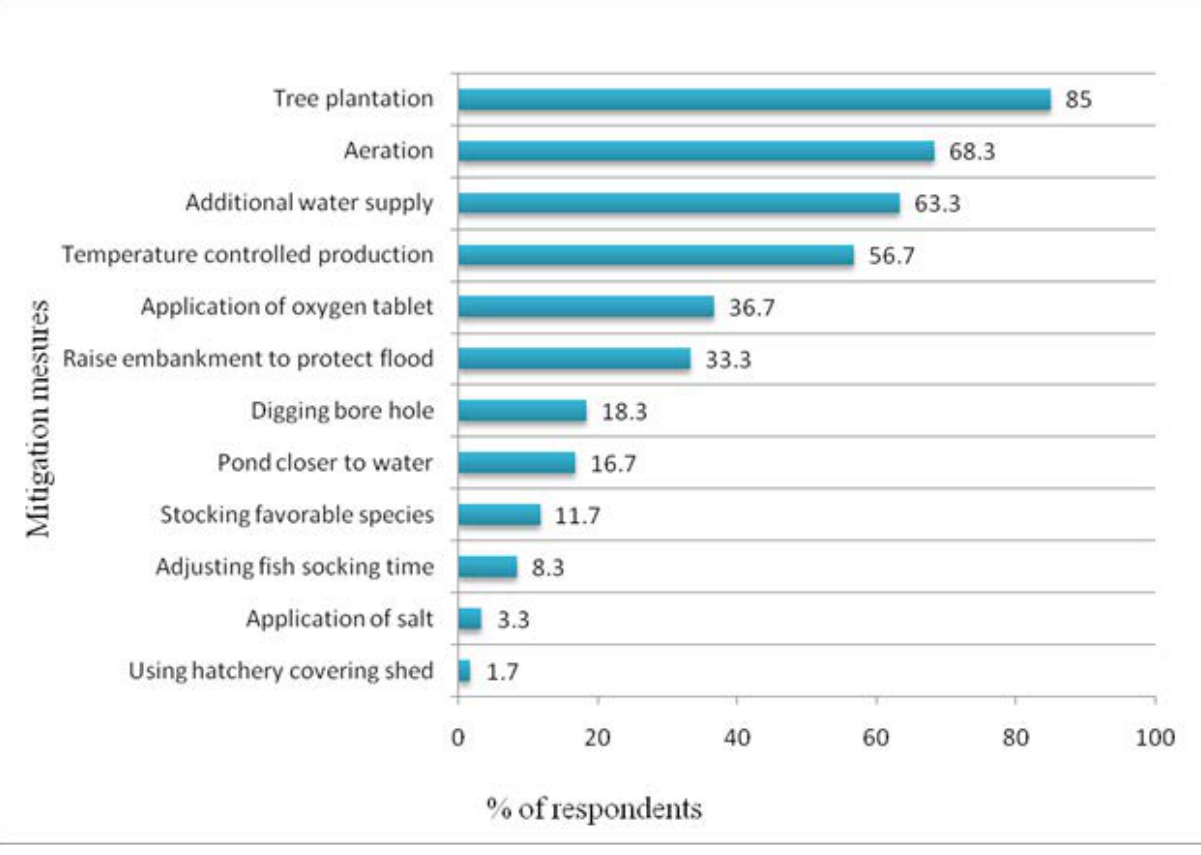
Figure 4. Responses of hatchery owners towards mitigation and adaptation to climate change.